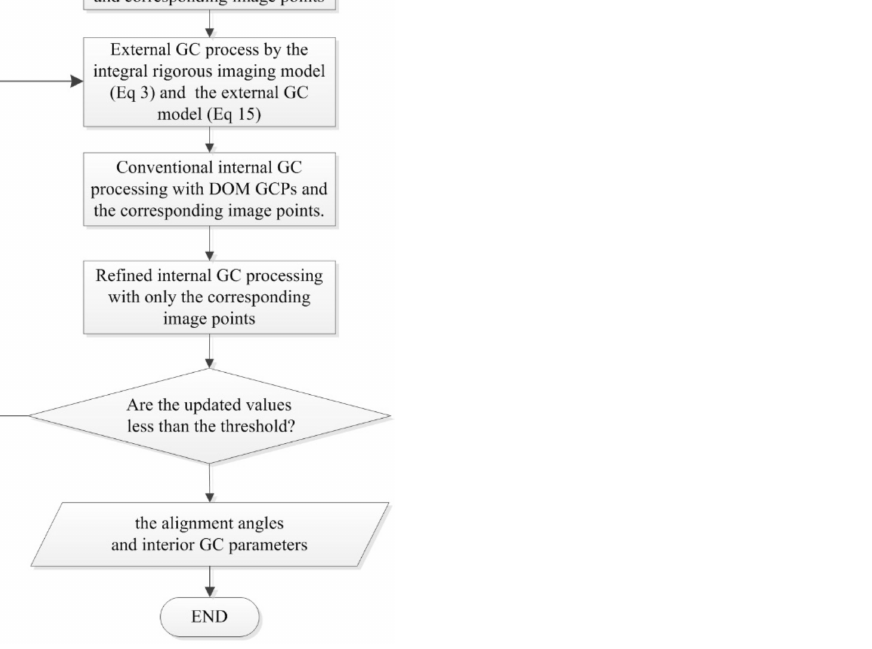
Figure 5. Workflow of the integral geometric calibration implementation scheme for the spliced satellite optical camera based on inter-chip geometry